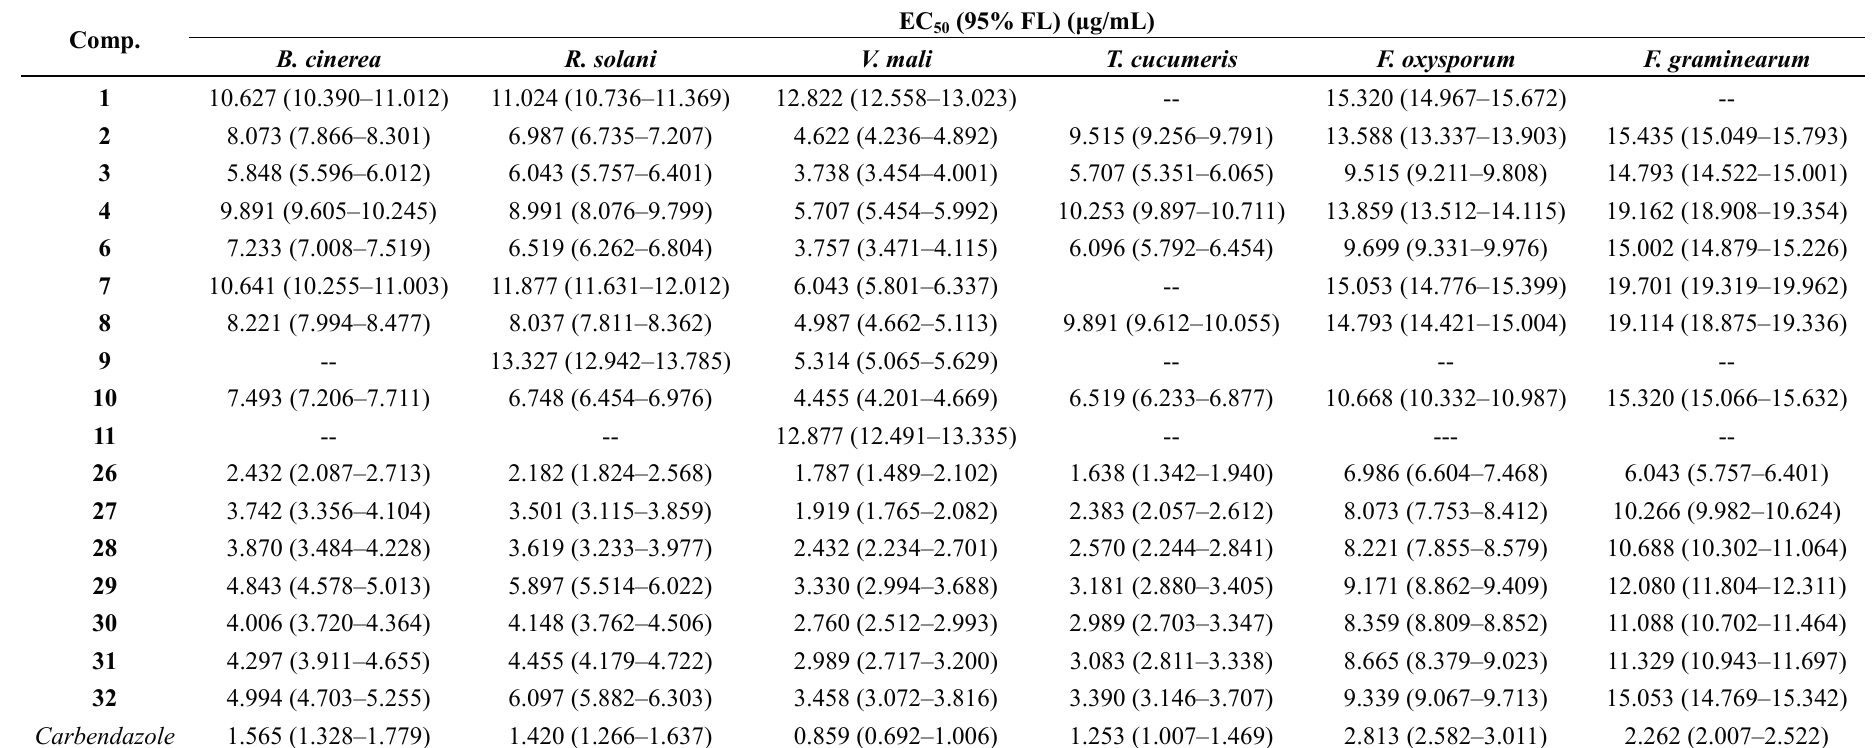
Table 2. Rescreening data of fungicidal activity of the synthesized compounds.